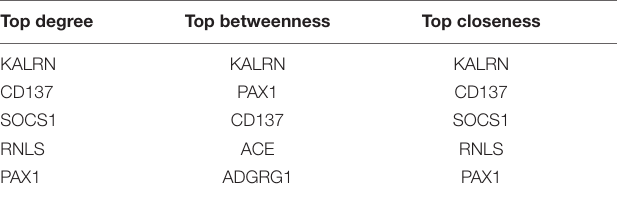
TABLE 3 | The top five mRNA with largest degree, betweenness and closeness in mRNA-mRNA